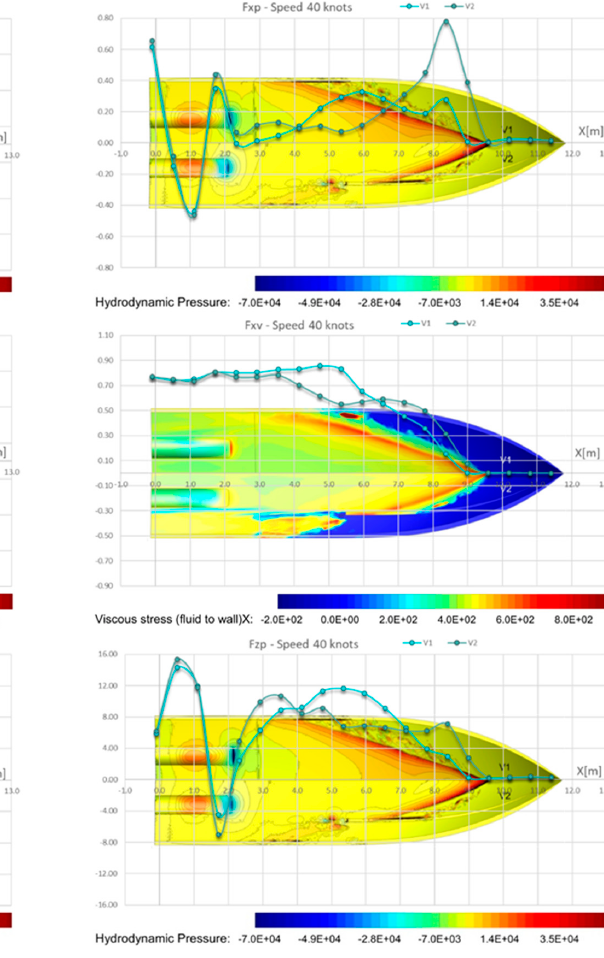
Figure 14. Forces and pressure distributions comparison for V1 and V2, at 36 and 40 kn.